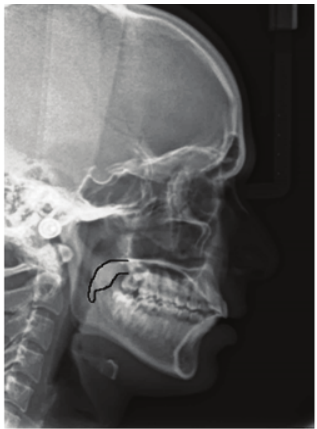
Figure 5: Crook shape seen on lateral